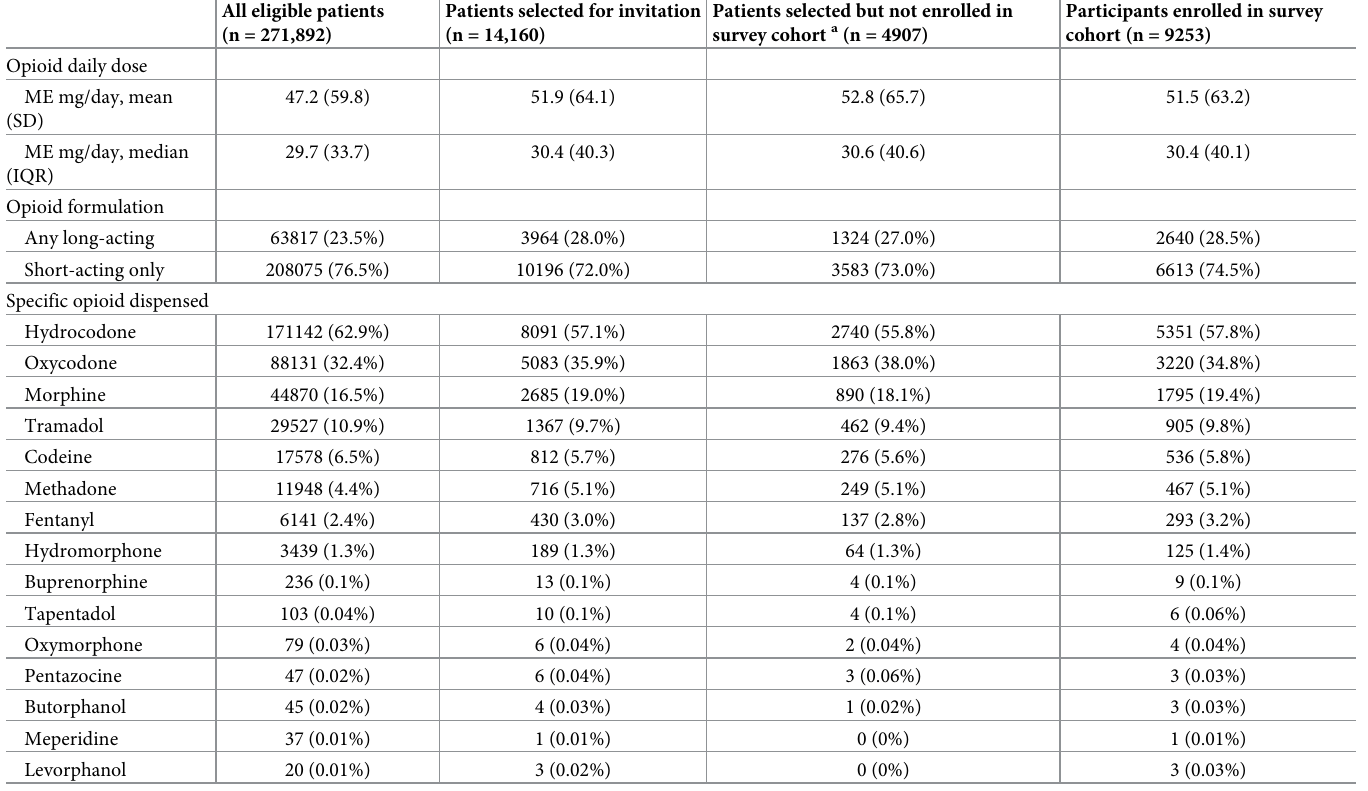
Table 2. Characteristics of EPOCH-eligible patients by study participation status at index date. All eligible patients Patients selected for invitation (n = 271,892) (n =